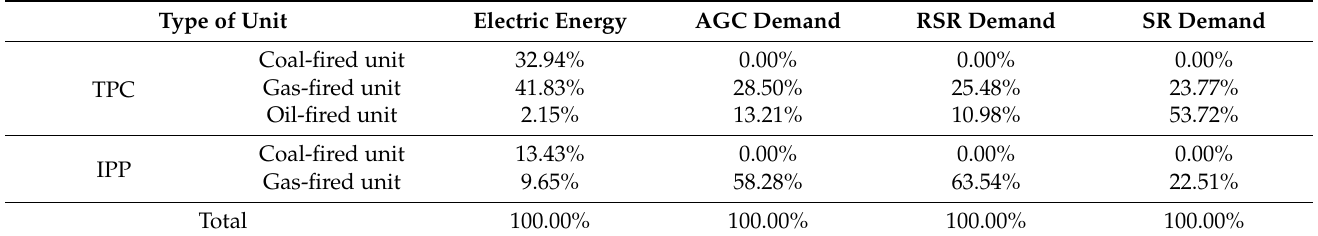
Table 4. Proportions of various units on a typical summer day.